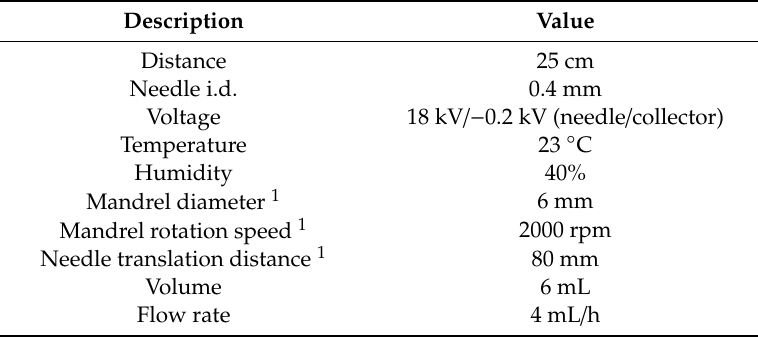
Table 1. Process conditions for electrospinning planar and tubular sca ff